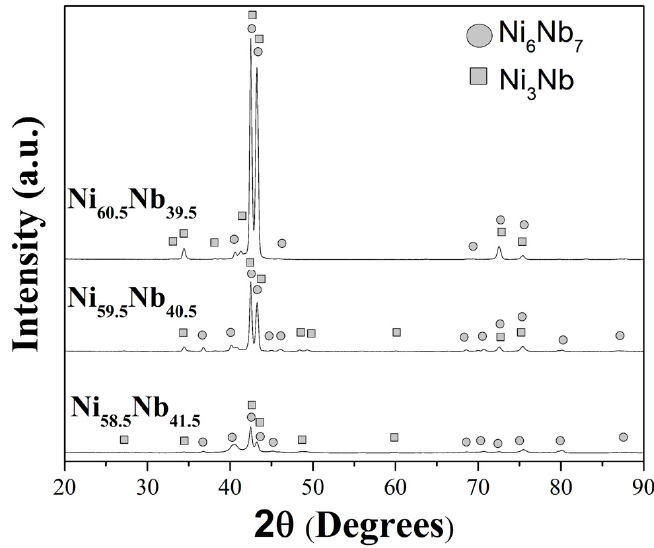
Figure 1. XRD patterns of ingots Ni 58.5 Nb 41.5 , Ni 59.5 Nb 40.5, and Ni 60.5 Nb 39.5 alloys.